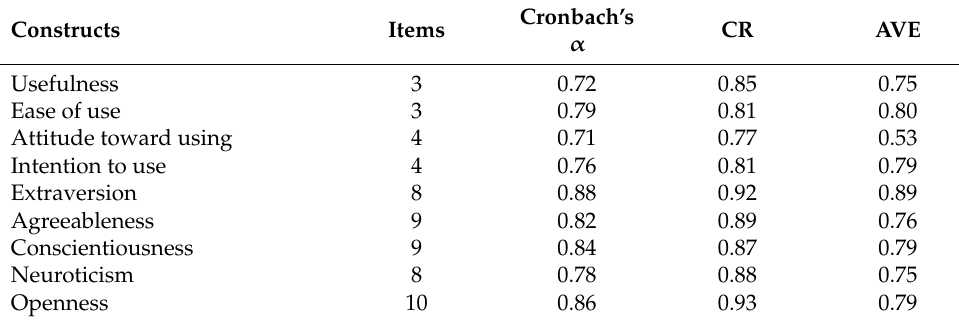
Table 3. Validity and reliability of the measurement model.